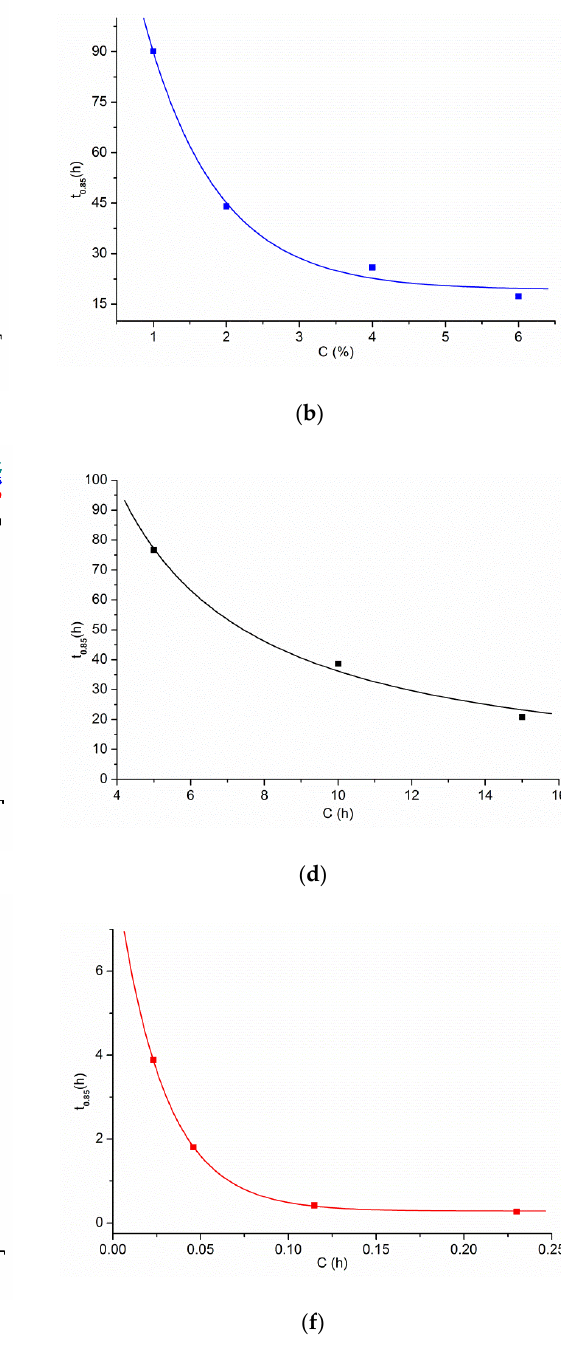
Figure 5. Graphs showing gelatin content after biodegradation test of samples crosslinked with different compounds and with varying conditions (left) and f ( C ) = t 0.85 (right) for: ( a , b ) genipin, ( c , d ) BDDGE, ( e , f ) EDC/NHS. In graph ( f ), C refers to EDC concentration. All presented data were fitted with an exponential function.